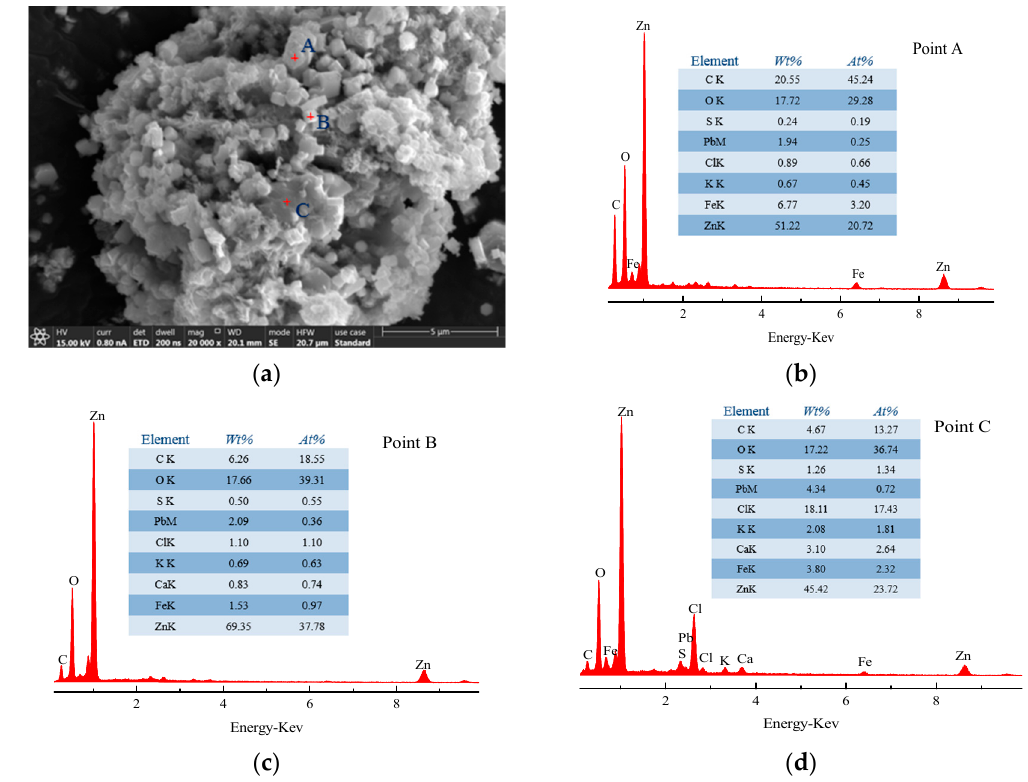
Crystals 2021 , 11 , x FOR PEER REVIEW 12 of 15 bright large granular areas (point A), bright small granular areas (point B), and gray areas (point C). EDS analysis showed that zinc was more distributed in all areas; iron was mainly distributed in bright large granular area (point A); and Pb, S, Cl, and K were pri- marily found in gray areas (point C). The difference was that the surface of the leached residue sample was relatively complete in Figure 17. The sample mainly existed in two typical structures: amorphous (point A) and granular (points B and C) structures. EDS analysis showed that Zn and Fe were mainly distributed in the amorphous structure (point A), and Pb, Ca, and C were primarily found in the granular structure (points B and